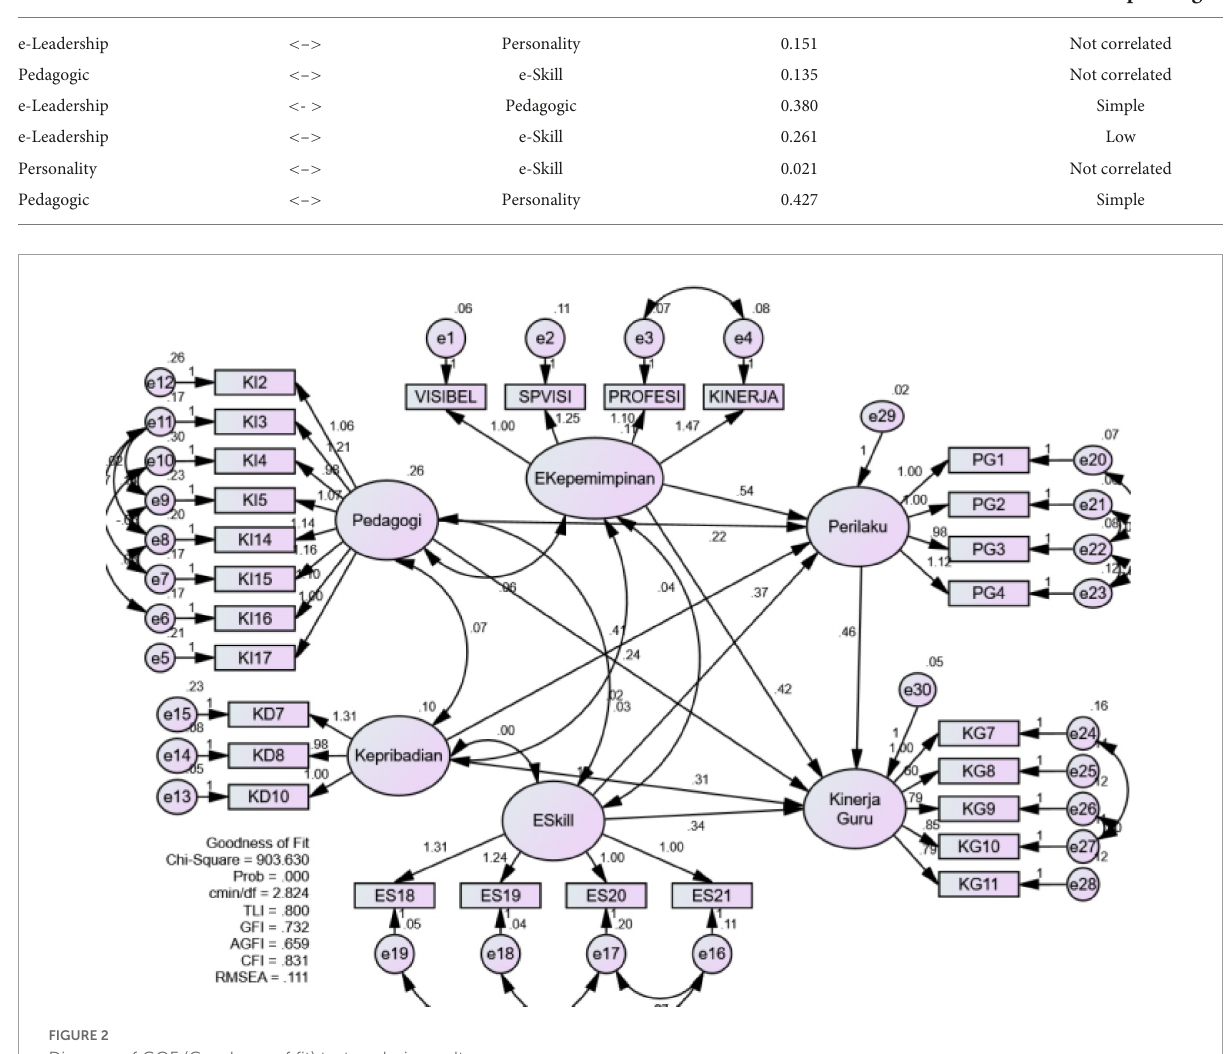
Based on the results of the analysis of Table 11 , it can be concluded that the correlation between each independent variable is below the correlation number < 0.50, this indicates